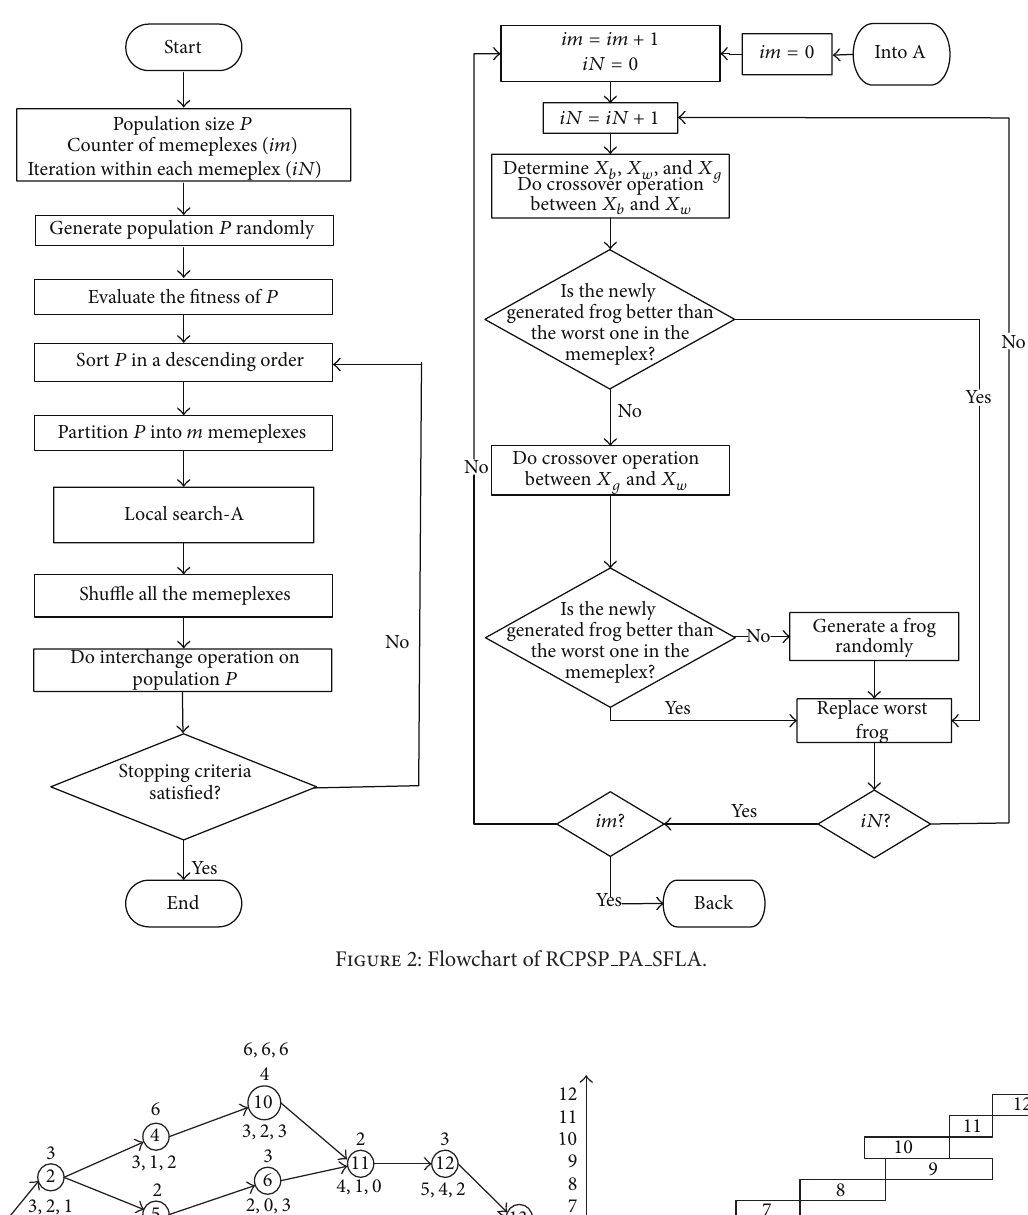
Figure 3: Project with 13 activities and its corresponding Gantt